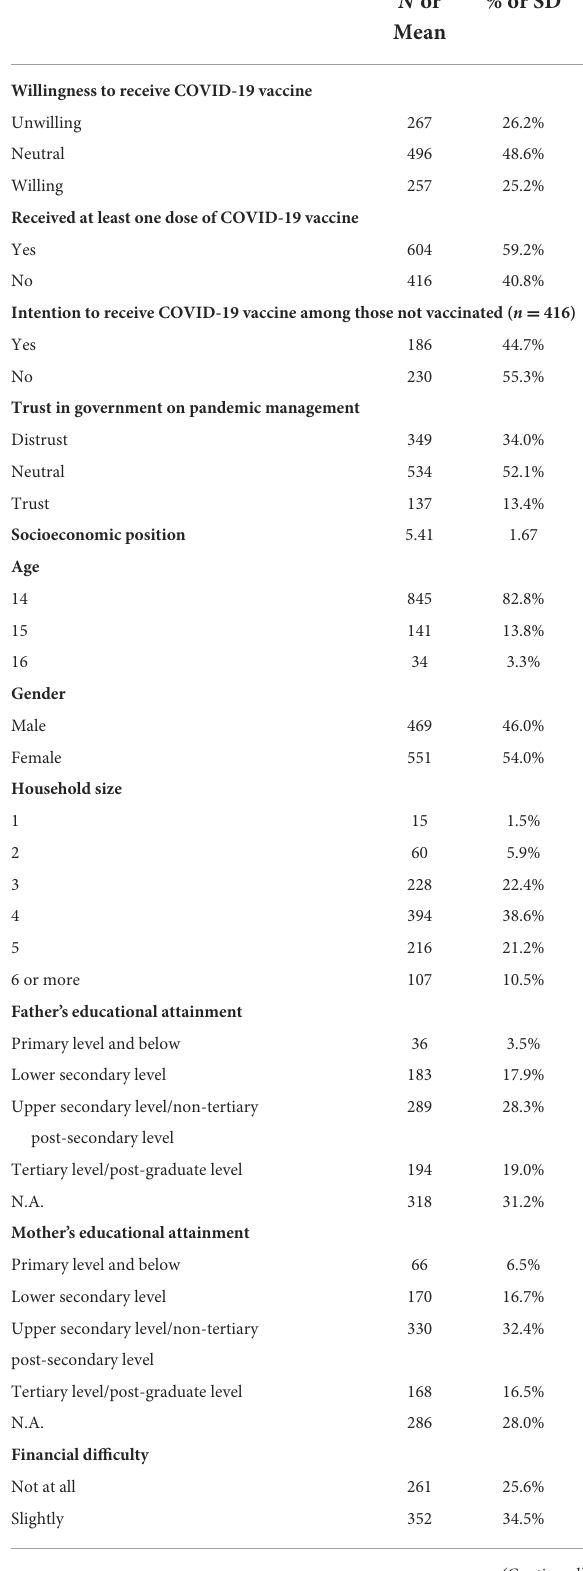
TABLE 1 Descriptive statistics of respondents ( n =